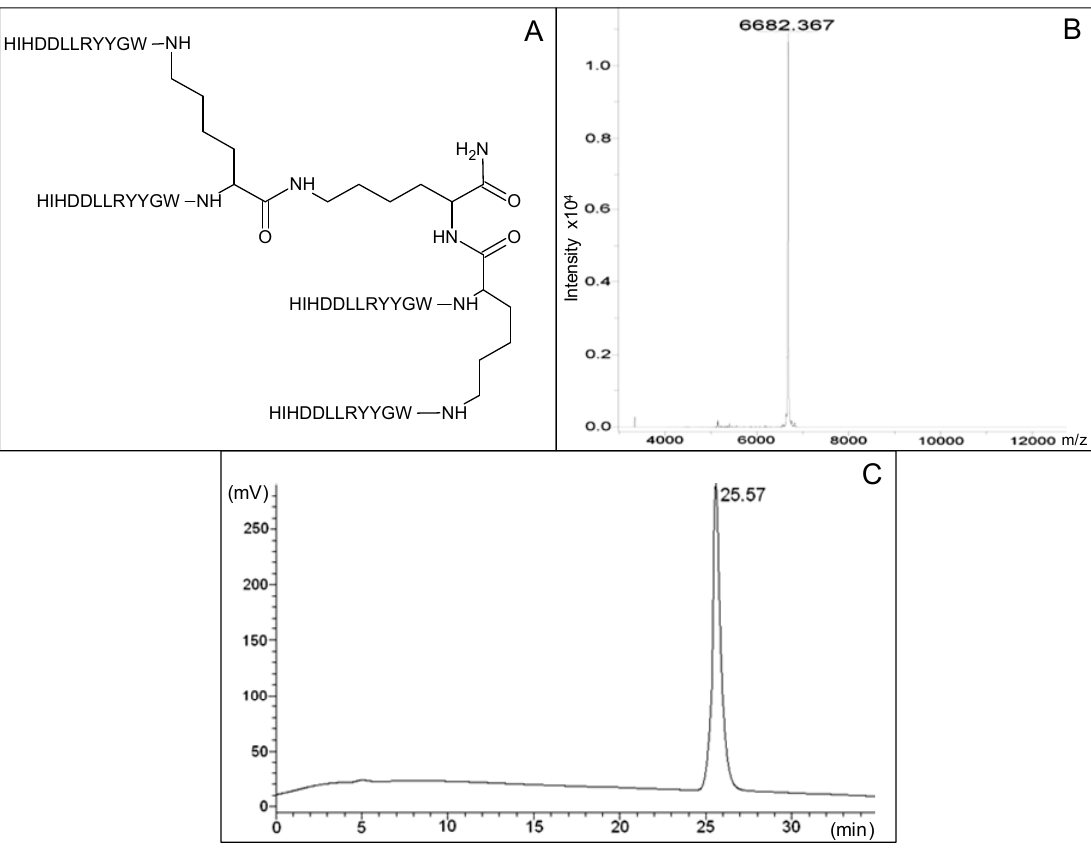
Figure 1. ( A ) Structure of human anti-TNF- α peptide synthesized in tetra-branched form. Amino acids of the four peptide sequences are indicated as one letter code. ( B ) MS profile of purified peptide, analysis of sample was performed with a Bruker Daltonic ultraflex MALDI TOF/TOF mass spectrometer. MW is indicated. ( C ) RP-HPLC profile of human anti-TNF- α peptide after purification. Retention time is